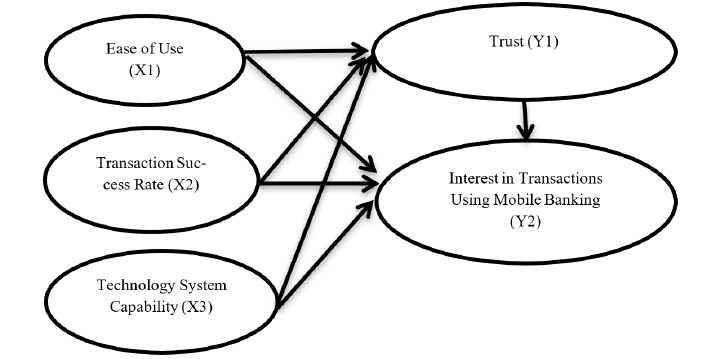
Fig. 1. Conceptual Framework